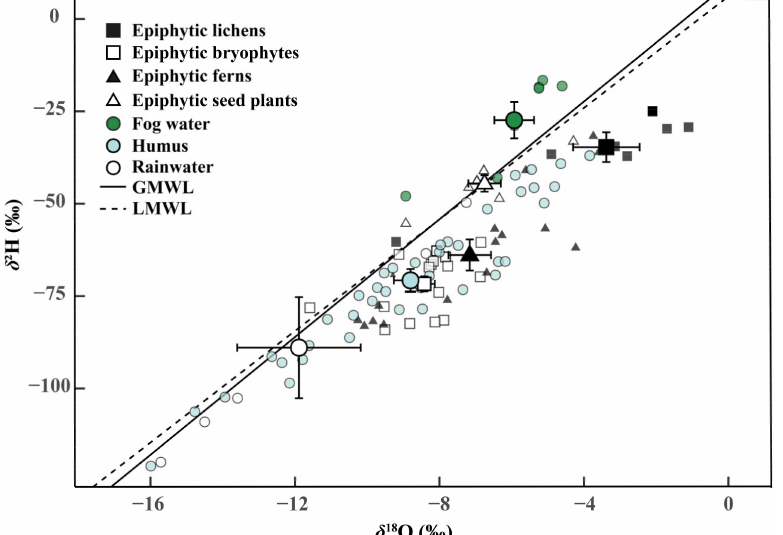
Figure 2. Average hydrogen and oxygen isotope ratios ( δ 2 H and δ 18 O) of epiphytes (Epiphytic lichens, n = 4 species; Epiphytic bryophytes, n = 4; Epiphytic ferns, n = 4; Epiphytic seed plants, n = 4) and water sources (Fog water, n = 7; humus, n = 4; and rainwater, n = 5) in the dry season (January 2019). The solid and segmented lines represent the global meteoric water line (GMWL: δ 2 H = 10 + 8 δ 18 O) and the local meteoric water line (LMWL: δ 2 H = 6.23 + 7.55 δ 18 O, R 2 = 0.86, p < 0.001), respectively. The LMWL was calculated by linear regression of the δ 2 H and δ 18 O of local precipitation data from 2018 to 2019. Error bars represent mean ± SE of epiphytes and water sources.